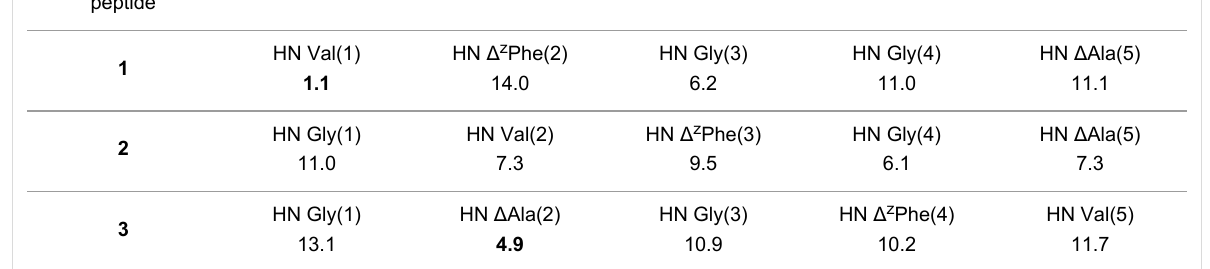
Table 1: Temperature dependence of the chemical shifts of amide protons of the investigated peptides – temperature coefficient d δ /dT [ppb/K]. peptide